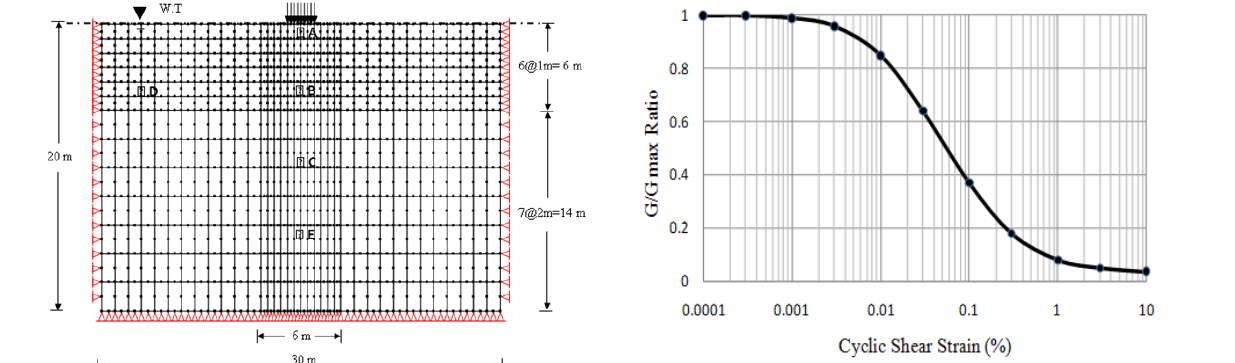
Figure 1. Typical finite element mesh.